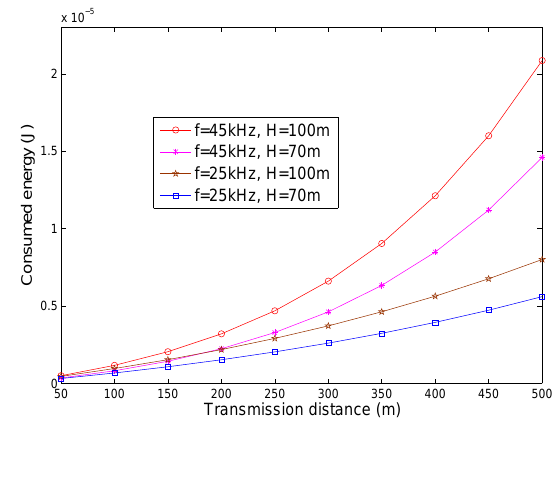
Figure 8. Energy dissipation vs sensor nodes in shallow water.